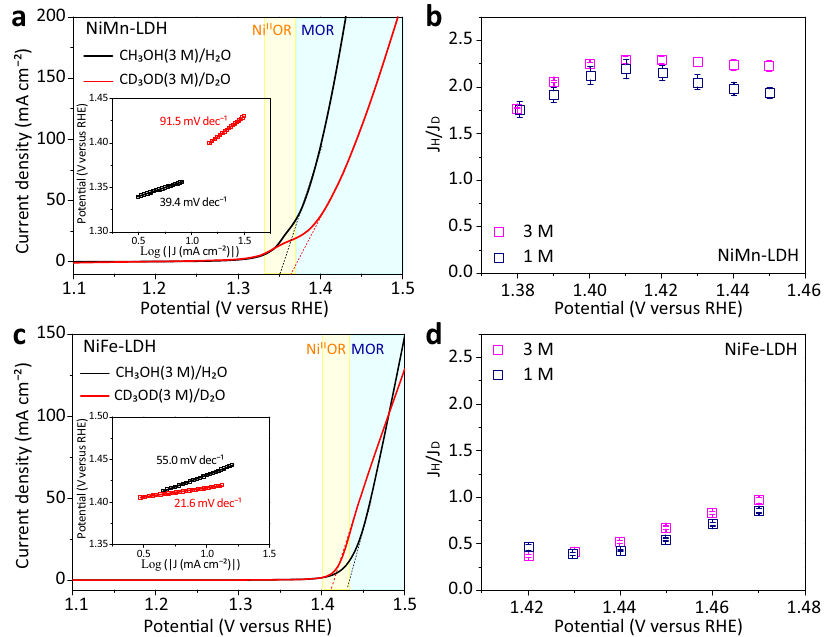
Fig. 4 | H/D KIE studies. a CV curves (only anodic sweep is shown for clarity) of NiMn-LDH recorded in alkaline CH 3 OH (3M)/H 2 O and CD 3 OD (3M)/D 2 O, respec- tively. Ni II OR refers to Ni II oxidation reaction, and the dash line indicates the occurranceofMOR.InsetshowsTafelplots. b H/DKIEplotsofNiMn-LDH(J H andJ D refertothecurrentdensitiesobtainedinalkalineaqueousanddeuteriumsolutions